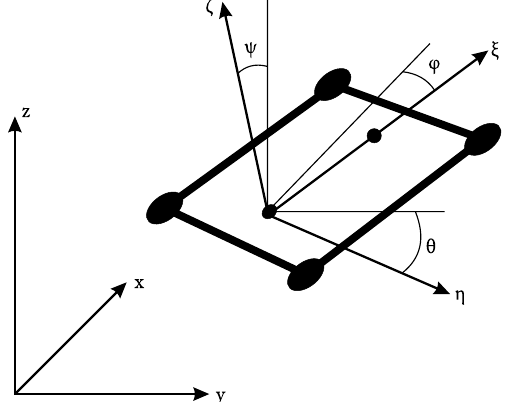
Fig. 6. Comparison of GNSS versus tracking total station